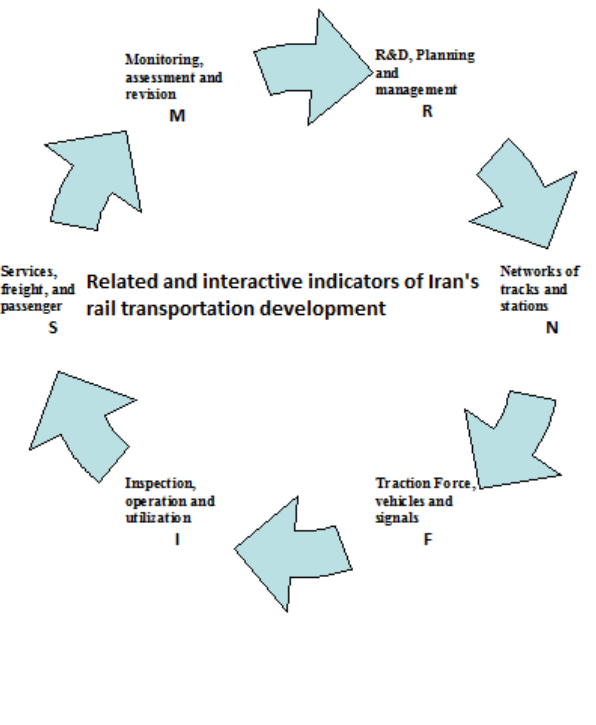
Figure 3: Connected and interactive indicators to study the railroad transportation